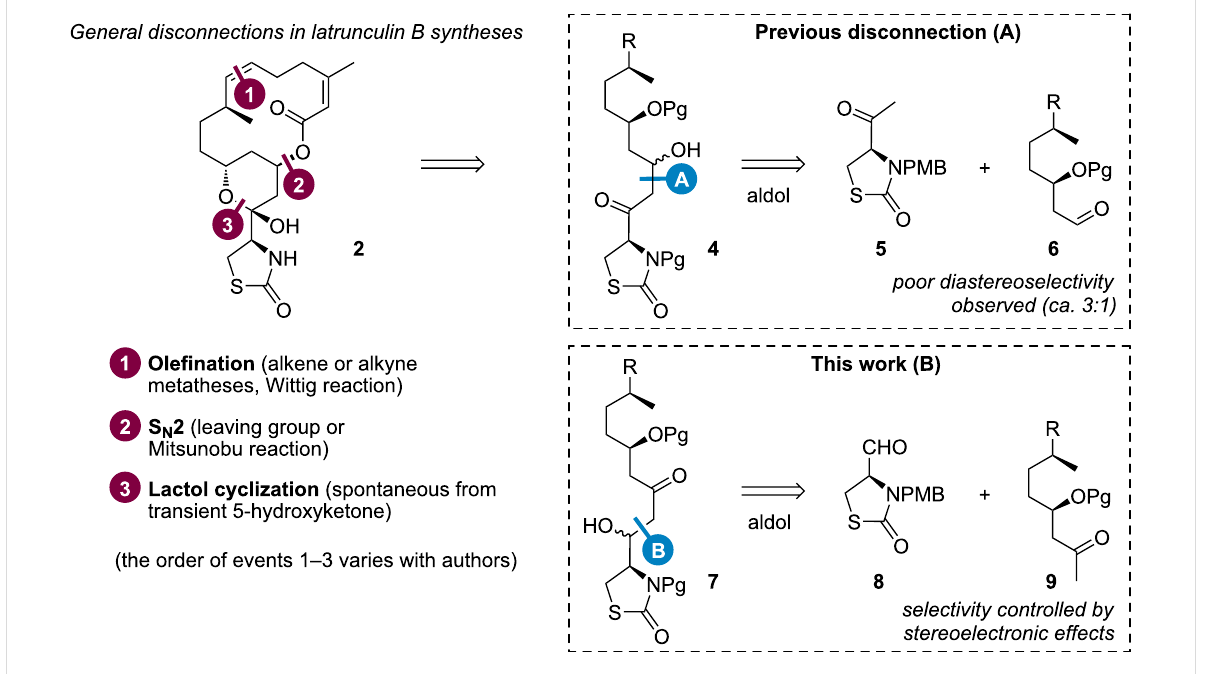
Considering the structural features of these toxins and their valuable biological properties ( 1 and 2 are nowadays commer- cially available as tools for cell biology), latrunculins have been appealing targets for synthetic studies. Several total syntheses of latrunculins were reported by Smith III [8-10], White [11], Fürstner [6,12] and Watson [13]. These syntheses involved sim- ilar disconnection strategies for the macrocycle or the lactol for- mation (Figure 2, left), and for the aldol reaction leading to 4